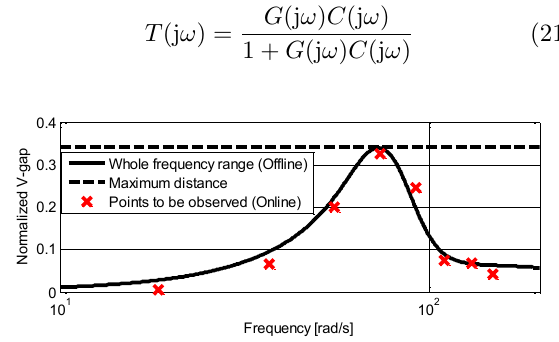
Figure 9: Frequency-based Vinnicombe gap. The solid black line is the distance of the offline- identified system models, and the dashed line is the maximum distance between them. The distances of the online-identified models at a selected set of frequencies are indicated by